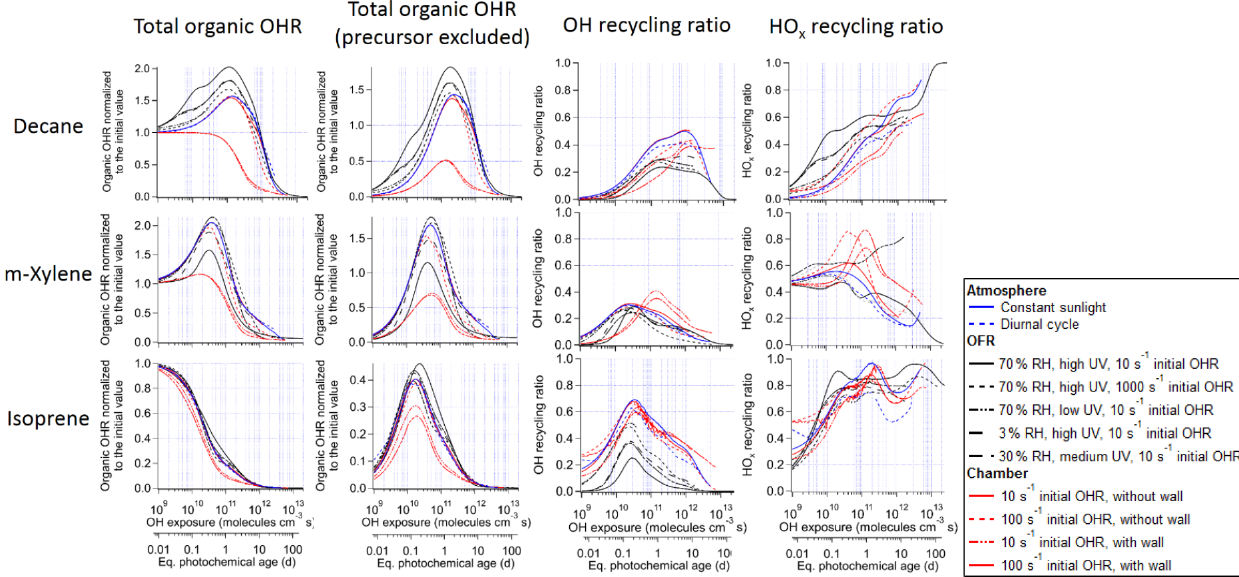
Figure 1. Total organic OH reactivity (OHR) with and without the contribution of the precursor, OH recycling ratio ( β 1 ), and HO x recycling ratio ( β 2 ) as a function of OH exposure (or equivalent photochemical age; second x axis) in the photooxidations of decane, isoprene, and m -xylene under different conditions in the atmosphere, oxidation flow reactor (OFR), and